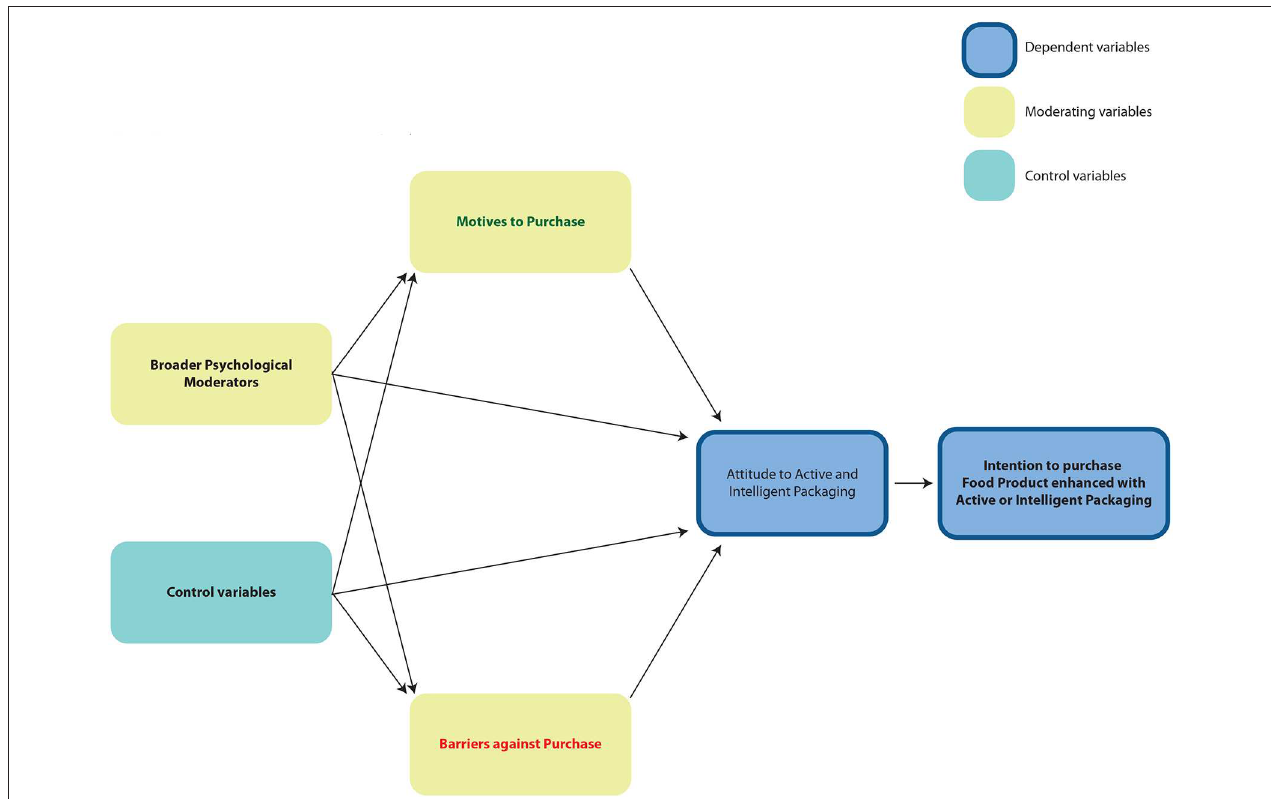
FIGURE 7 | Initial conceptual framework on motives, barriers and purchase decisions.